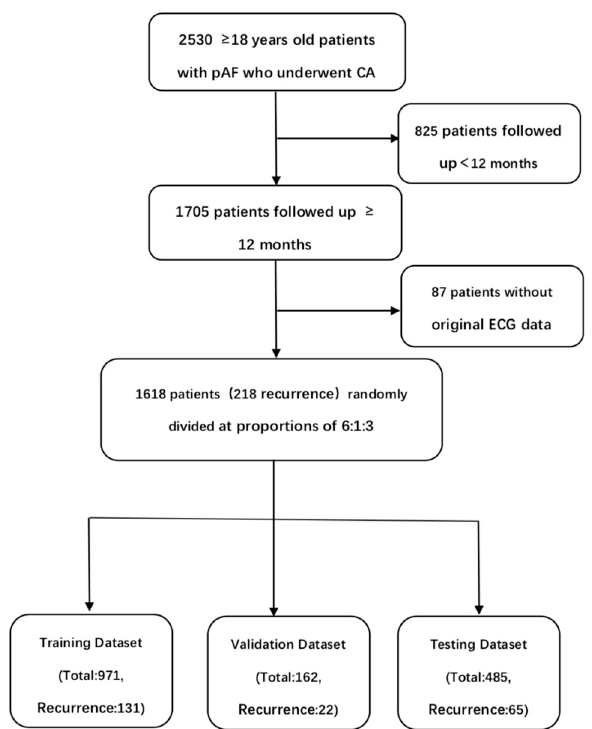
Figure 1. Patient flow diagram.